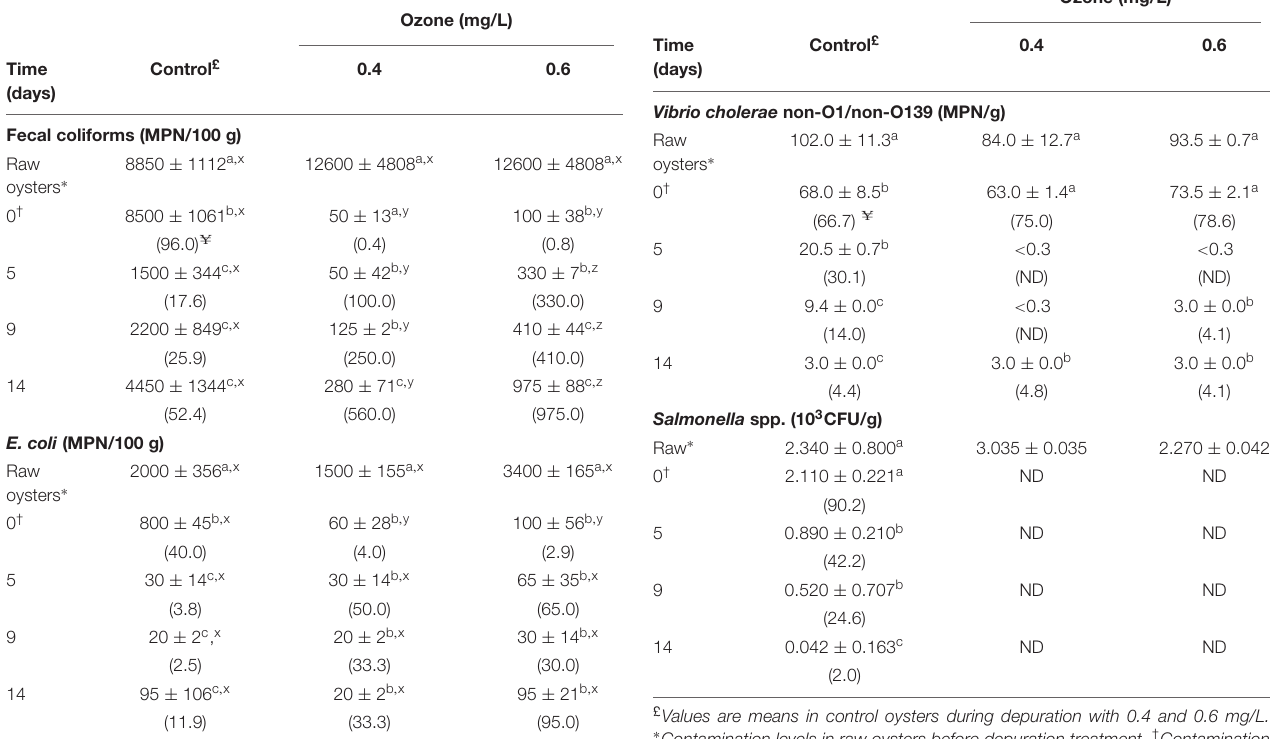
TABLE 3 | Retention rates and changes in Fecal coliforms and Escherichia coli levels in naturally contaminated American oyster ( Crassostrea virginica ) depurated with ozonated seawater and superchilled stored at − 1 ◦ C.